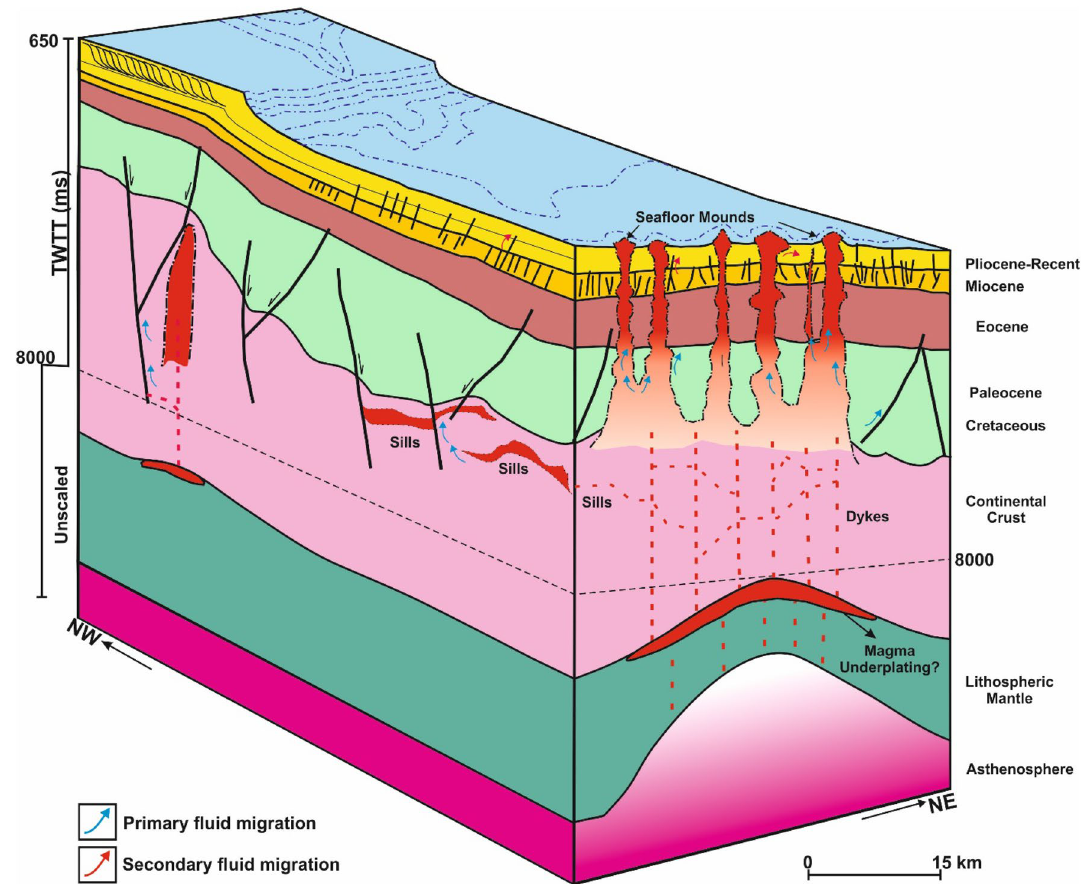
Figure 11. Conceptual diagram showing the link between the seafloor mounds, their vertical conduits and the fluid pumping system in the study area. Figure inspired by 97 and 12 . TWTT: Two-way travel time in milli-